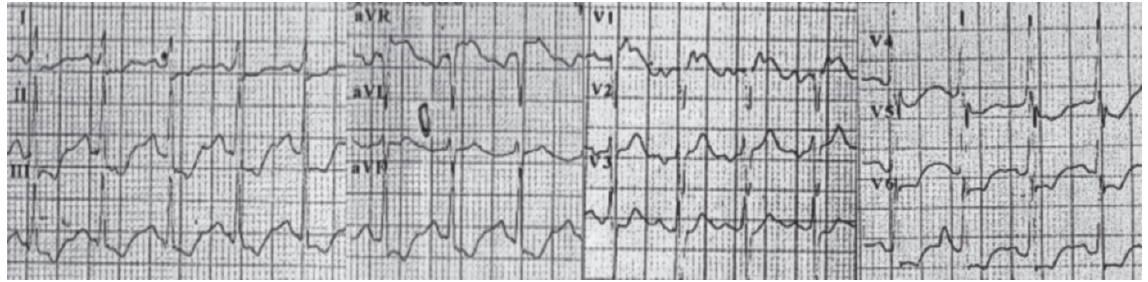
Figure 3. Case 3: Accelerated idioventricular rhythm 91-85 beats/minute with ST-T changes in inferior leads. (Figure 1, Figure 2), and accelerated idioventricular rhythm (AIVR) in the third case (Figure 3 ). Other significant laboratory changes were elevated blood glucose (ranged 6.93-8.52 mmol/l), and white blood cell count ranged 19.7-25.4 x 10 3 . Repeated determination of cardiac enzymes, troponin T, electrolytes, renal function, and liver function showed normal values, during hospitalization. A clinical diagnosis of scombroid was established. The plasma histamine level was not measured in ED due to technical difficulties. All three patients underwent emergency resuscitation with intravenous fluids (crystalloid solutions 2000 ml in 1 hour followed by 80 ml/hour infusion for the next 6 hours) and